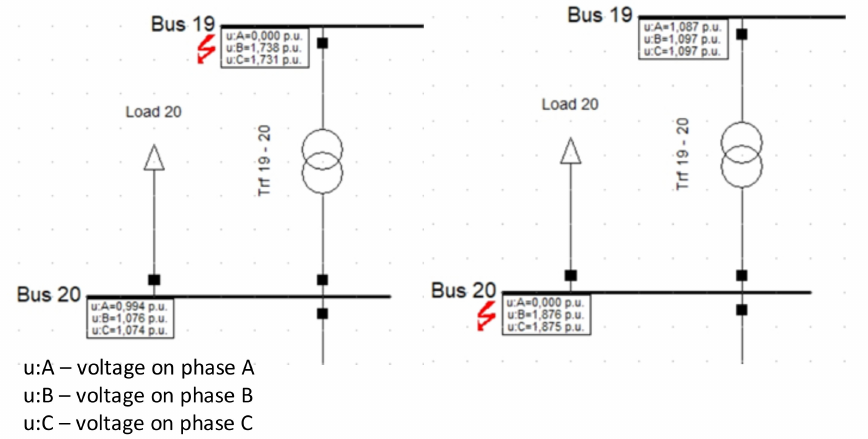
Figure 5. A single-phase short circuit at buses 19 and 20, which are connected by transformer Trf 19–20 in YNy